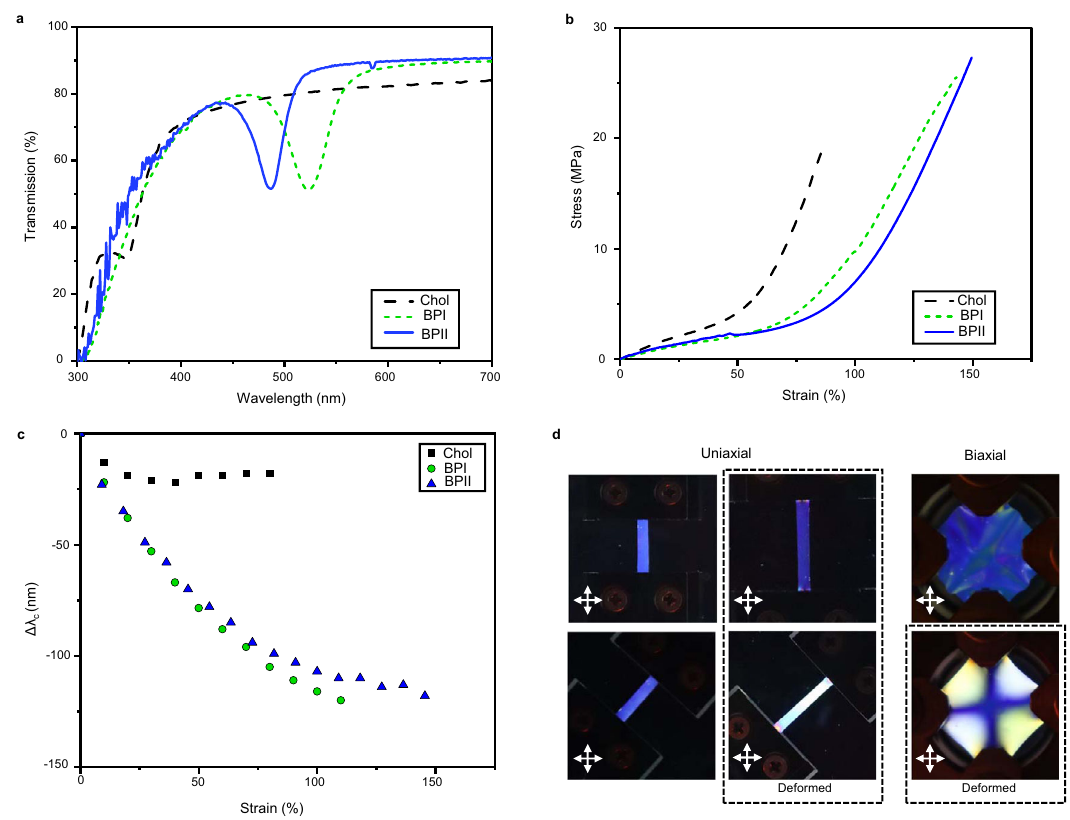
Fig. 2 Optical properties and effects due to mechanical deformation. a Transmission spectra of elastomers retaining the cholesteric phase, blue phase I (BPI), and blue phase II (BPII) showing selective re fl ection bands as measured through incident light to the surface of the elastomer. b Stress – strain behavior of cholesteric, blue phase I, and blue-phase II elastomers. c Change in selective re fl ection of elastomers retaining the cholesteric phase, blue phase I (BPI) and blue phase II (BPII) as a function of uniaxial strain. d Birefringence patterns induced by uniaxial or biaxial mechanical deformation of blue-phase I elastomer. Observed as photographs through crossed